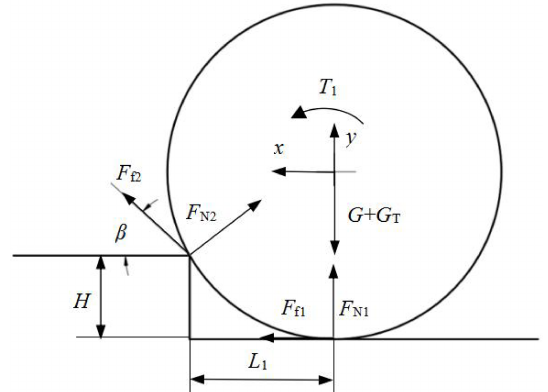
Figure 8. Forces on the mechanism for